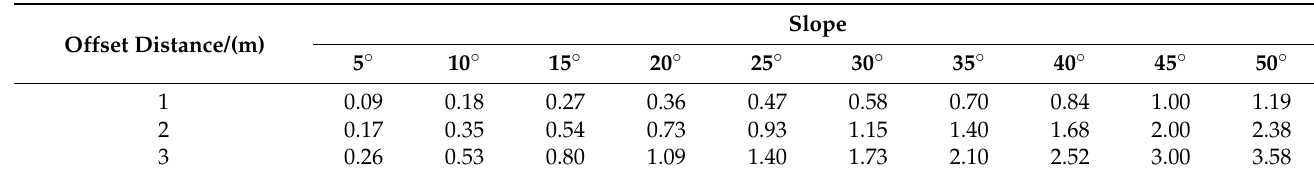
Figure 6. Effect of slope on canopy height estimates at different slope locations: ( a ) canopy height retrieved on flat land; ( b ) canopy height retrieved on a uphill slope; and ( c ) canopy height retrieved on a downhill slope. Table 2. Maximum error of canopy for different